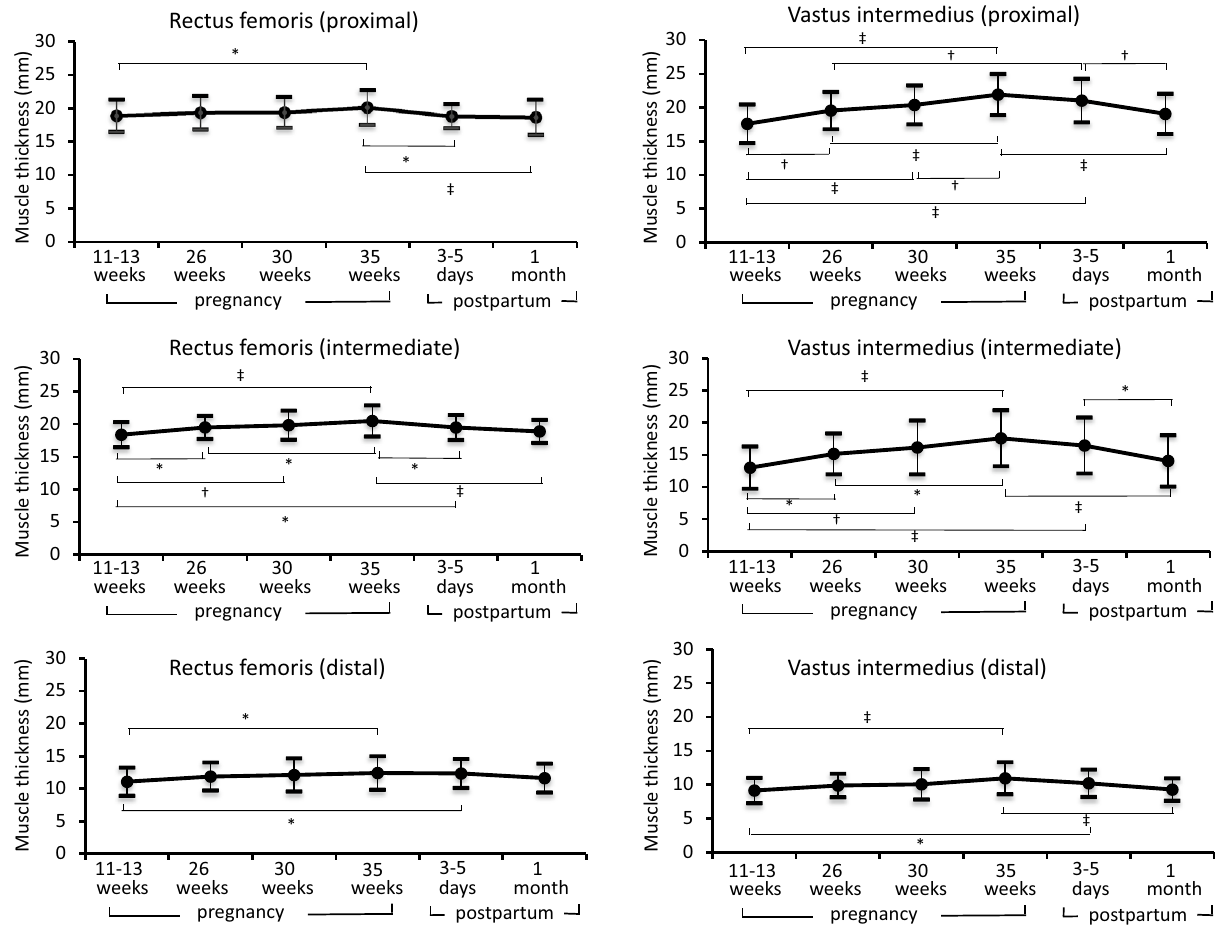
Figure 1. Changes in the muscle thickness in women with normal pregnancy. Changes in the muscle thickness of the rectus femoris (proximal, intermediate, and distal points) and vastus intermedius (proximal, intermediate, and distal points) in women with normal pregnancy are shown. Data are presented as mean ± standard deviation (*p < 0.05; † p 0.01; ‡ p < for TPL were significantly (p < 0.01) lower than those in women with normal pregnancy (26 weeks: 3.5 ± 1.7 vs. 5.4 ± 1.7 kg, 30 weeks: 4.5 ± 2.3 vs. 7.0 ± 2.1 kg, 35 weeks: 6.2 ± 2.9 vs. 8.7 ± 2.4 kg). There was no significant difference in the body weight at 1 month postpartum between the two groups. In contrast, the loss in body weight (absolute value) during the postpartum period in women on bed rest was significantly lower than that in women with normal pregnancy (4.8 ± 2.2 vs. 7.4 ± 2.6 kg, p < 0.01). The median and interquartile range (IQR) of total physical activities at 30 and 35 weeks of pregnancy in women on bed rest were significantly (p < 0.001 and p < 0.001, respectively) lower than those in women with normal pregnancy (30 weeks of pregnancy: 0 [0 to 0] vs. 1942.5 [856.5 to 4254.0], 35 weeks of pregnancy: 0 [0 to 0] vs. 1254 [881.3 to 2161.5] metabolic equivalents (METs)-min/week). However, there was no significant difference in the total physical activity at 1 month post- partum between women on bed rest and women with normal pregnancy. There were no significant differences between the two groups in the rate of nulliparity, rate of vaginal delivery, and intake of calories and protein from 30 weeks of pregnancy to 1 month postpartum. Changes in the muscle thicknesses of rectus femoris and vastus intermedius in women on bed rest during pregnancy. There were no significant changes in muscle thickness from 30 weeks of pregnancy to 1 month postpartum at all six sites in the longitudinal study. Comparison of the muscle thickness between women with normal pregnancy and women on bed rest during pregnancy. At 30 weeks of pregnancy, there were no significant differences in the muscle thickness measurements at all six sites between women with normal pregnancy and women on bed rest. Muscle thicknesses measured at the proximal, intermediate, and distal points of the vastus intermedius and interme- diate point of the rectus femoris at 35 weeks of pregnancy in women on bed rest were significantly (p < 0.01, p < 0.01, p < 0.01, and p < 0.05, respectively) lower than those in women with normal pregnancy (18.7 ± 3.0 vs. 21.9 ± 3.1 mm, 13.8 ± 2.7 vs. 17.6 ± 4.4 mm, 9.0 ± 1.6 vs. 10.9 ± 2.4 mm, and 18.2 ± 3.4 vs. 20.5 ± 2.4 mm, respec-